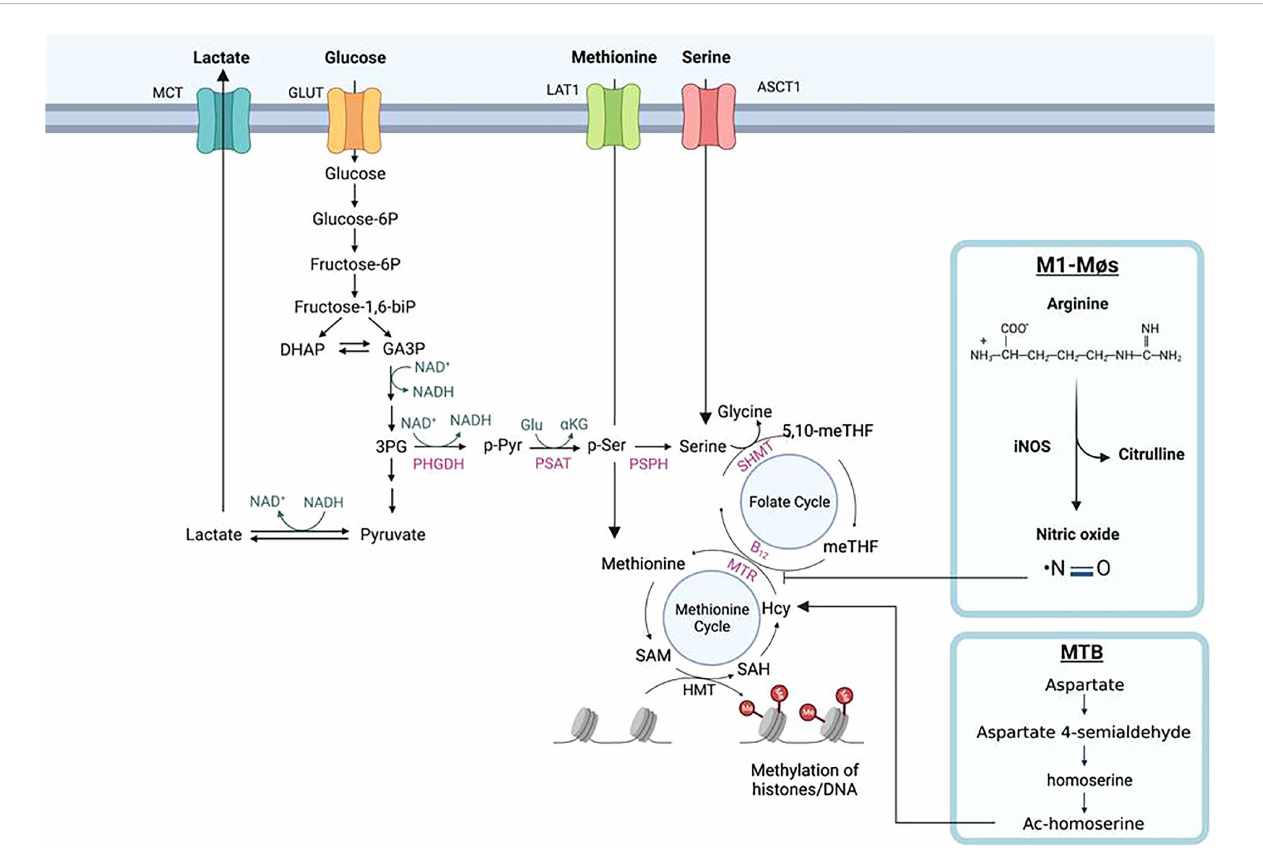
FIGURE 6 Histone methylation through one-carbon metabolism and serine biosynthesis in macrophages. Serine is biosynthesized from 3-phophoglycerol (3PG), an intermediate of glycolysis, by phosphoglycerol dehydrogenase (PHGDH) to form phosphopyruvate (p-Pyr) and catalyzed by phosphoserine aminotransferase (PSAT) to form phosphoserine (p-Ser) and then phosphoserine phosphate (PSPH) to form serine. With the aid of catalytic enzyme serine hydroxymethyltransferase (SHMT), serine is further converted into glycine donating one-carbon (a methyl group) to the tetrahydrofolate (THF) in the folate cycle to form sequentially 5, 10-methylenetetrahydrofolate (5,10-meTHF) and 5-methyl-tetrahydrofolate (meTHF); the methyl group of the latter is transferred to homocysteine (Hcy) to form methionine (Met) and S-adenosyl-methionine (SAM). SAM is the co-substrate of methyltransferases for DNA and histone methylation. Methionine and serine can also be respectively delivered from extracellular environment to the cells by their transporters, L-type amino acid transporter/solute carrier family member 5 (LAT1/SLC7A5) and alanine/serine/cysteine/threonine transporter 1 (ASCT1). The methyl transfer from meTHF to Hcy needs methionine synthesis (MS/MTR) and its co-substrate vitamin B 12 . In M1-M F s, elevated nitric oxide (NO) poisons vitamin B 12 causing deactivation of MTR and the disruption of one-carbon metabolism, resulting in reduced Met and SAM for histones/DNA methylation. In Mycobacterium tuberculosis MTB) infected M F s, independent of vitamin B 12 , the pathogen can bypass the one-carbon metabolic pathway to synthesize methionine and SAM through homoserine, a product of aspartate metabolic